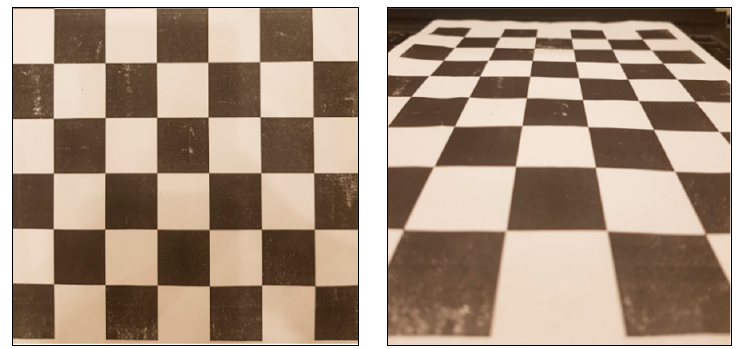
Figure 7. The checker board and the frontal view. Using the above transformation, the authors can construct the frontal view for a real-time motion to define the available area. Figure 8 shows the segmentation model’s output from frontal view images.